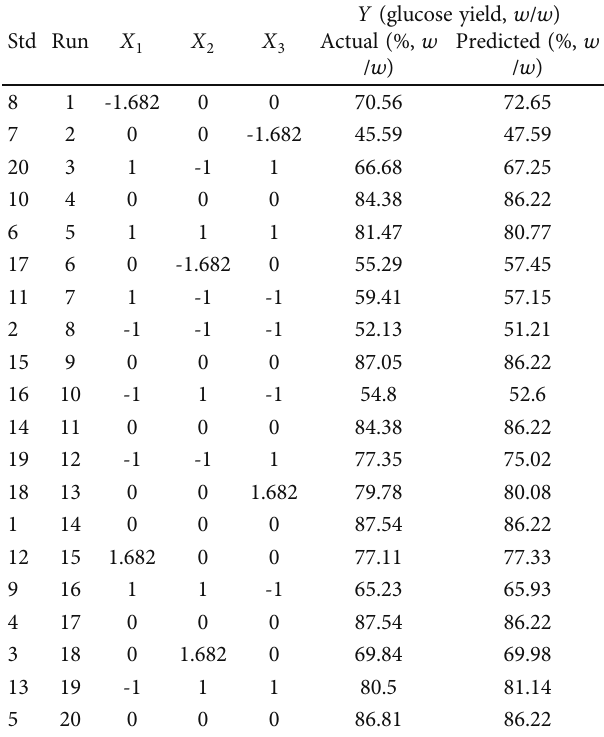
Table 3: Gadam sorghum stalks: chemical composition. Component